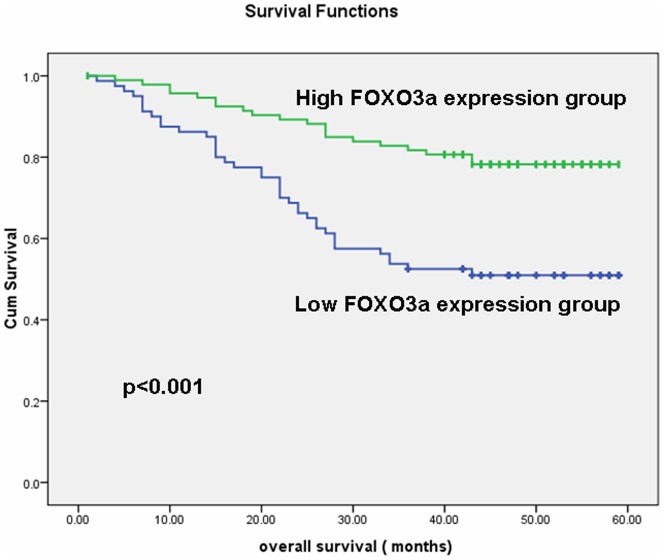
The Kaplan-Meier survival curves of gastric cancer patients (n = 174) after surgical resection.The gastric cancer patients were divided into low FOXO3a expression (FOXO3a- or FOXO3a+) and high FOXO3a expression (FOXO3a++ or FOXO3a+++) groups. Patients in the low FOXO3a expression group showed significantly poorer survival than those in the high FOXO3a expression group (log-rank test: p<0.001).